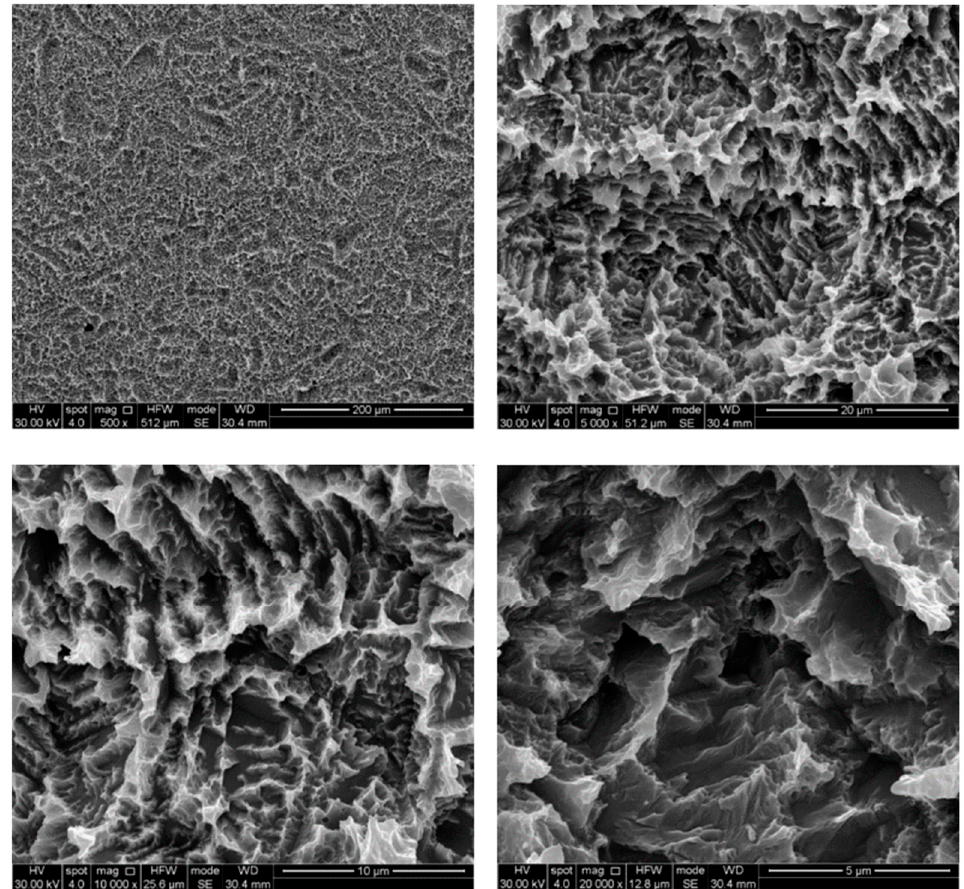
Figure 5. SEM images of diode laser at 3 W (L3) samples. No signs of alteration are visible. Magnifications from 500× to 20,000×.